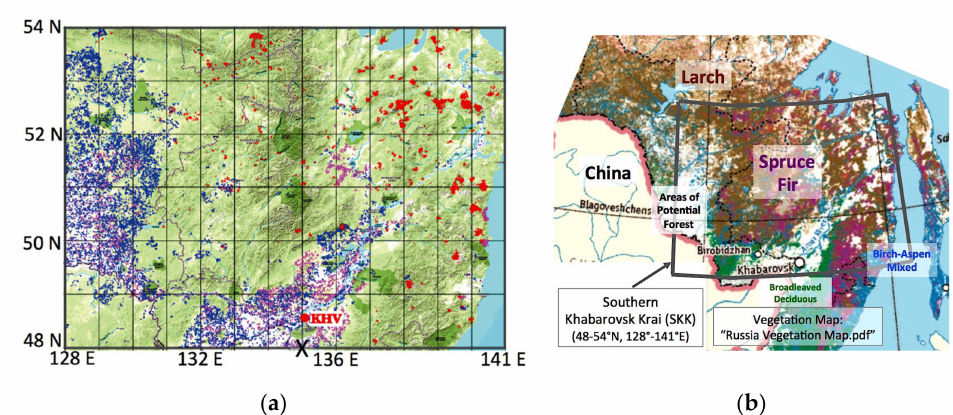
Figure 2. The study region and vegetation map in the southern Khabarovsk Krai (SKK). ( a ) The study region (48–54 ◦ N, 128–141 ◦ E) in SKK.; ( b ) Vegetation map of SKK region